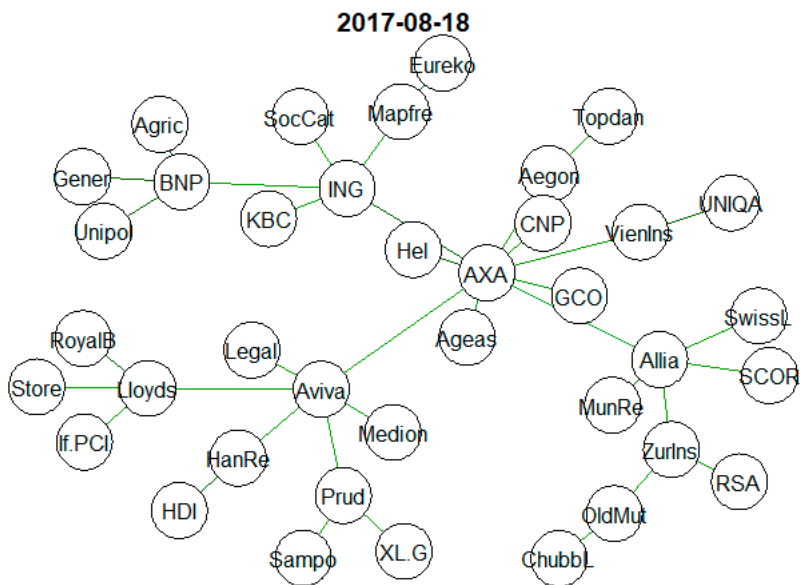
Figure 14. Sample MSTs in two chosen times. Source: Own study.